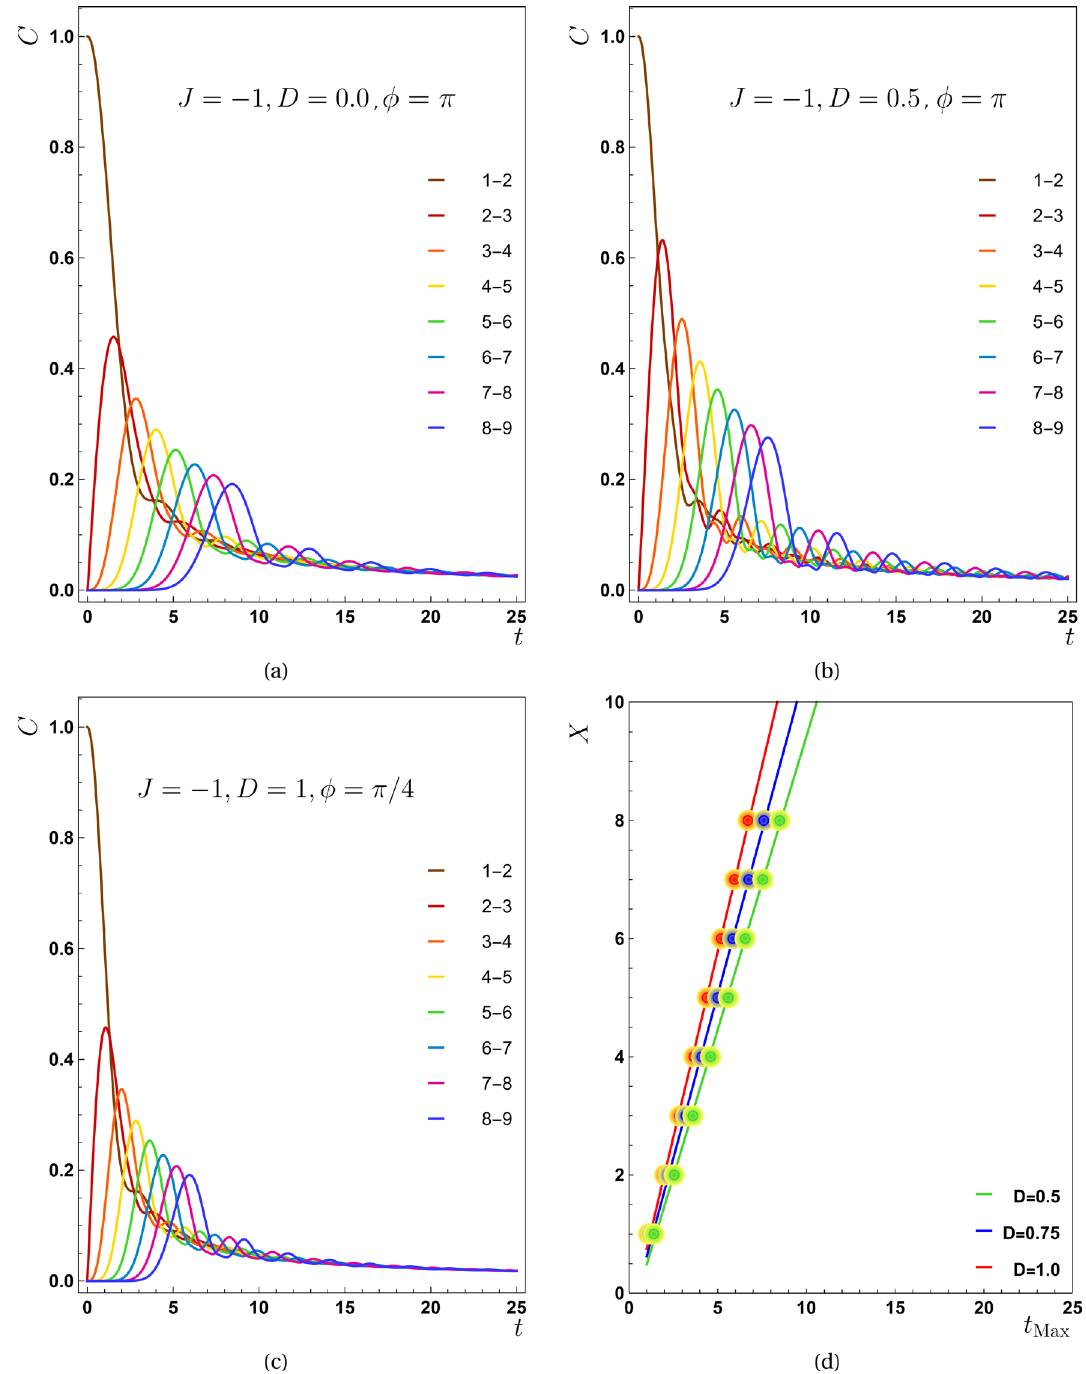
0.0, φ 0 ) the concurrence as a function of time t ( a ) D π , Figure 4. In the third scenario ( J < 0, D = = = 0.5, φ 1.0 . As D increases, the maximum value of 1.0, φ π , ( c ) D π/ 4 and for all plots J ( b ) D = = = − = = the concurrence function for the various pairs occurs in shorter time instances indicating V grows, however, t Max the maxima of concurrences do not grow (the details are explained in Fig. 5 b ). Panel ( d ) shows the X − 0.5 is 0.9930 0.0005 , for D 0.75 diagram for various values of D , from which the propagation speed for D = ± = 1.0 , this quantity equals with 1.1070 0.0005 and 1.2570 0.0005 and D = ± ±